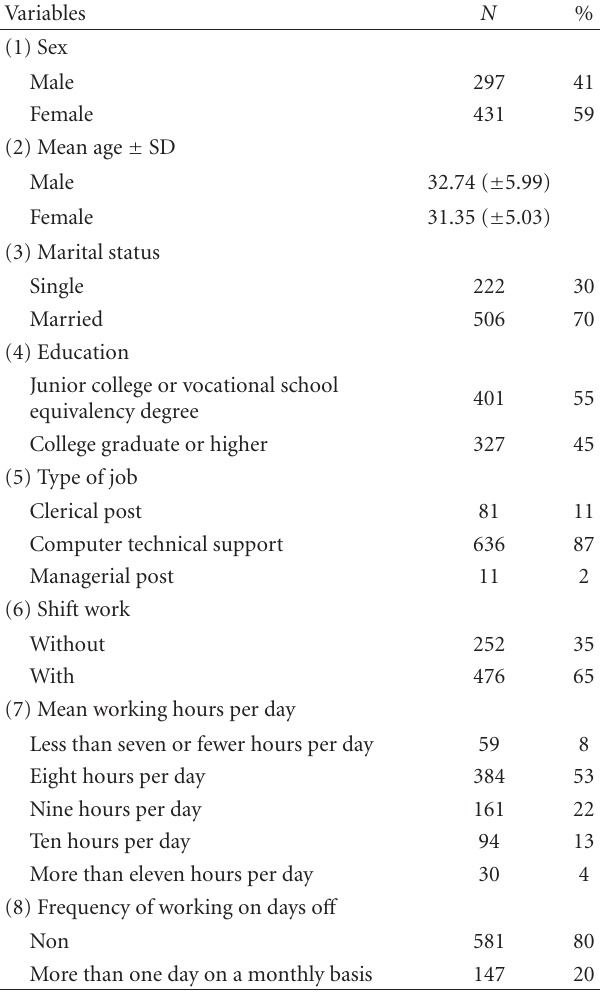
Table 1: Sociodemographic characteristics of the sample ( N